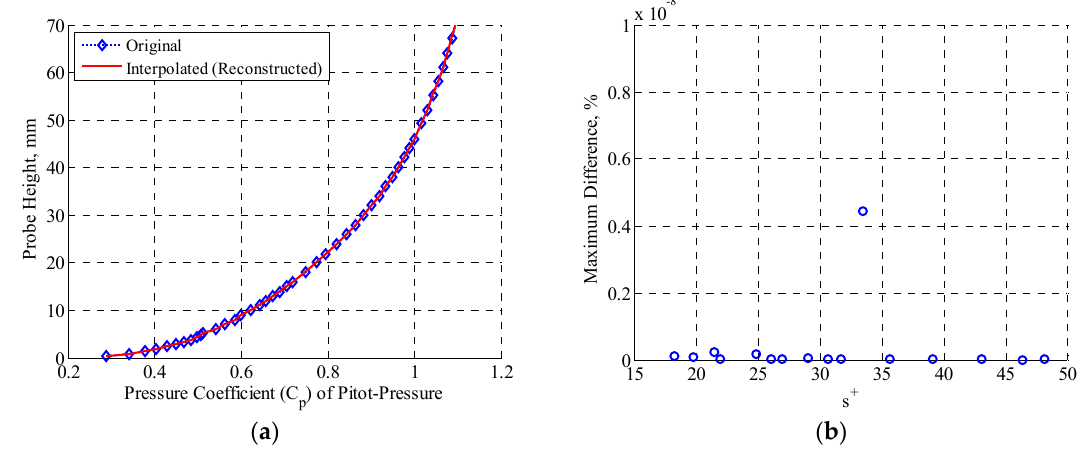
Figure 8. ( a ) Example case ( M ∞ = 0.65, α = 2°, P ∞ = 22.4 kPa, T ∞ = 235.0 K) of the original C p profile superimposed with the interpolated profile; and ( b ) maximum uncertainty presented in percentage among all pitot-probes for all measured flight cases caused by interpolation, along with flight experimental data for smooth wall cases.